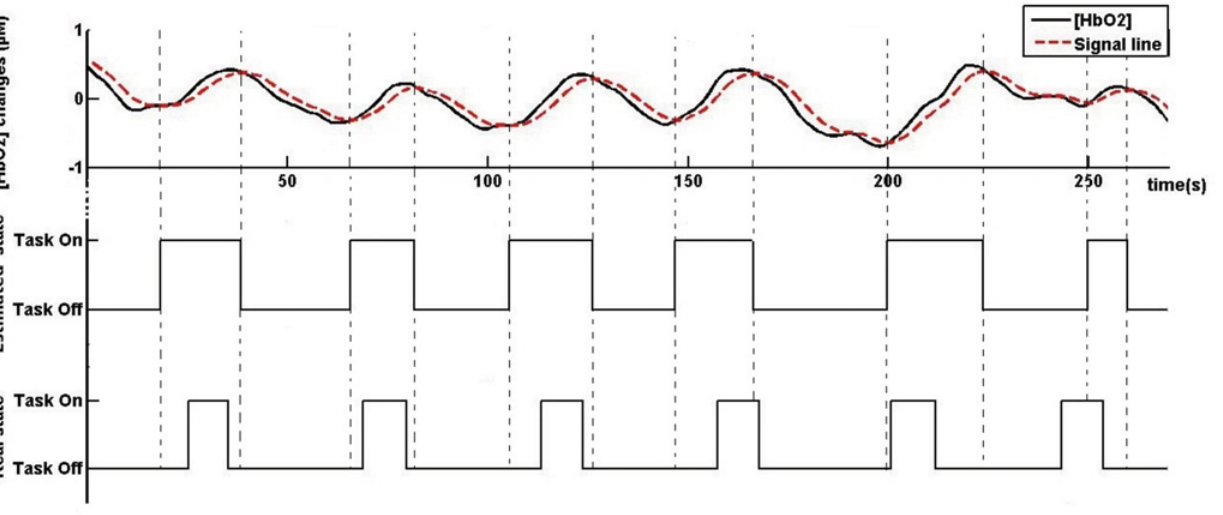
Fig 6. Example of real-time state estimation (performed on pilot 16). The upper graph shows MACD-filtered fNIRS signal and the signal line computed from the latter (dashed line). The two lower graphs show the participant ’ s state estimated from crossovers between MACD and signal lines and the operator ’ s actual state,